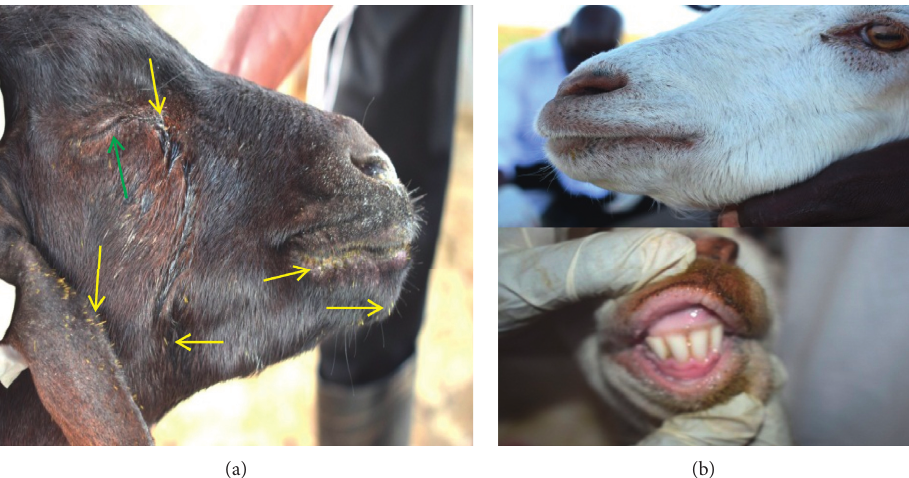
Figure 5: Spines on the ear lobe, face, eye lid, and lips (yellow arrows) and closed blind eye with ocular discharge (green arrow) (a) of goats that had consumed Opuntia stricta . Goats from Opuntia stricta -free ranches with clean face, eyes, lips, gum, and oral cavity with no observable spines on the external body parts